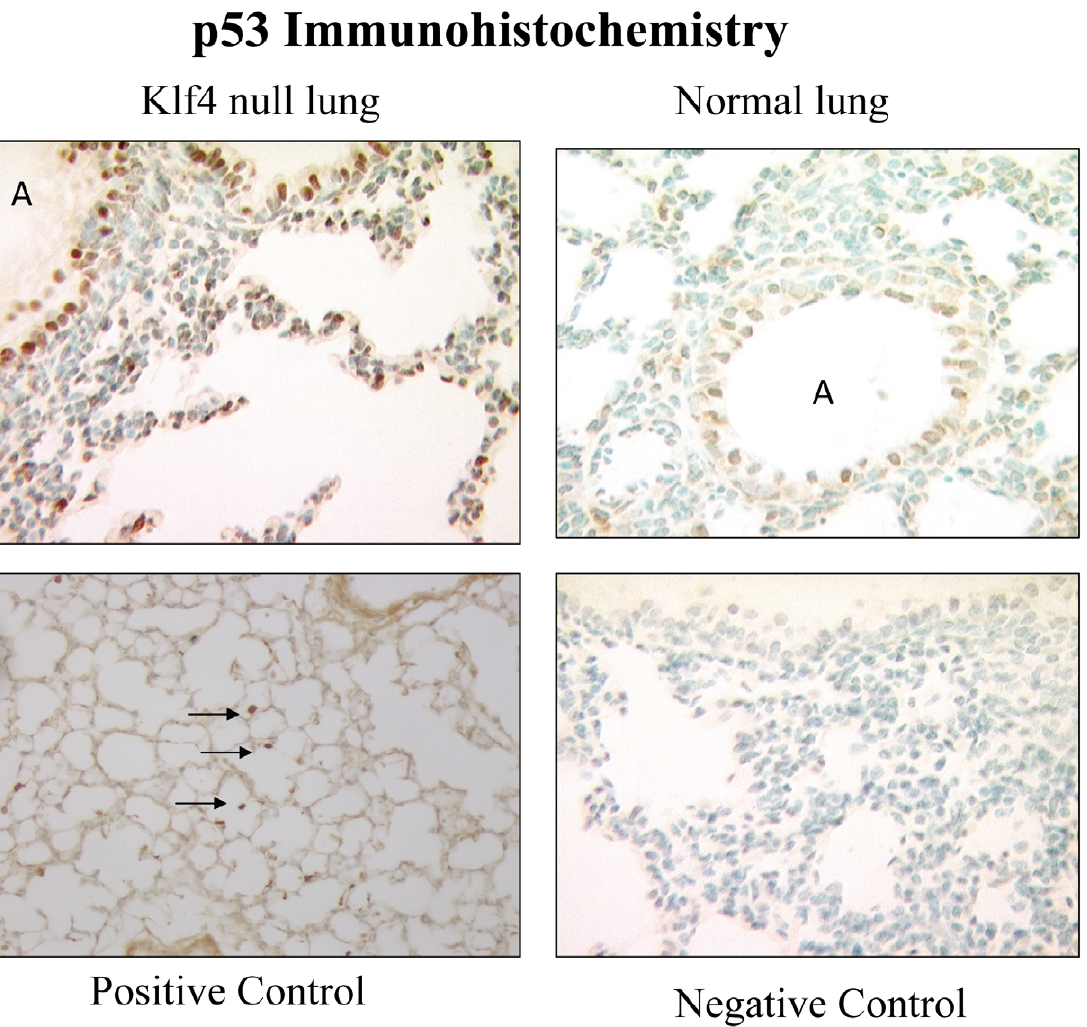
Figure 9. Nuclear localization of p53 protein. An intense immuno-histochemical signal (brown color) for p53 protein is present in numerous airway epithelial (A) and mesenchymal cells of newborn Klf4 null mouse lung (top left panel). Few cells in normal lung exhibit any signal (top right panel). Signal is present in macrophages of the hyperoxia-exposed GGT enu1 mouse lung (arrows) as a positive control [13] (bottom left panel). No signal is present with omission of primary antibody as a negative control (bottom right panel).